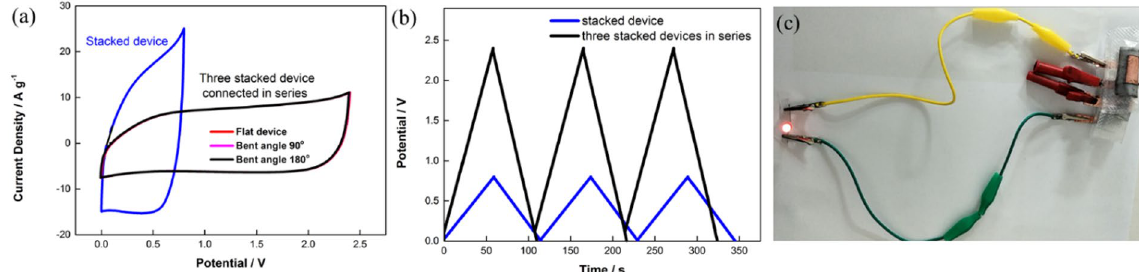
Figure 5. ( a ) CV profiles collected at different bending angles at 100 mV s − 1 . ( b ) GCD curves at 3 A g − 1 of a stacked supercapacitor and three stacked supercapacitors in series. ( c ) Image of a red LED powered by three 180° bent stacked supercapacitors in series.